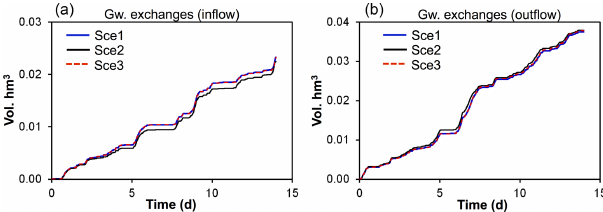
Figure 5. Volume of water that flows in (a) and flows out (b) the mine during the simulated